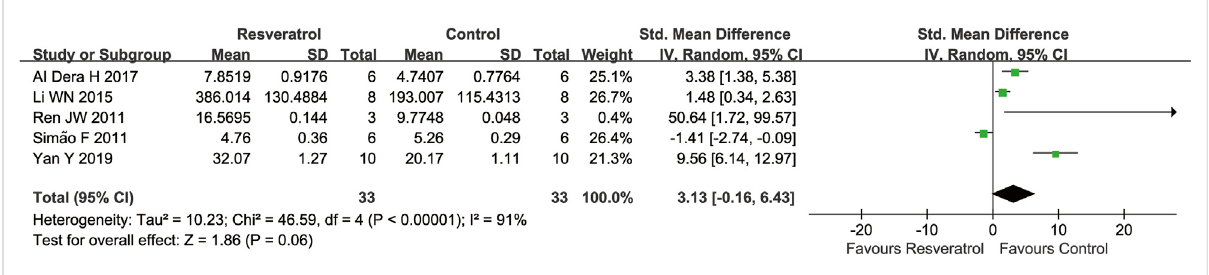
FIGURE 6 Meta-analysis of resveratrol for SOD in rats after cerebral I/R injury.